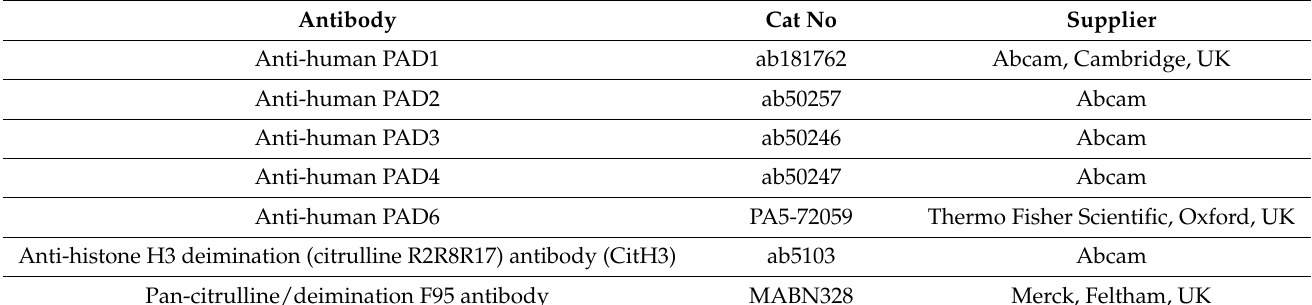
Table 3. Primary antibodies used for immunohistochemical detection in post-mortem human brain tissue